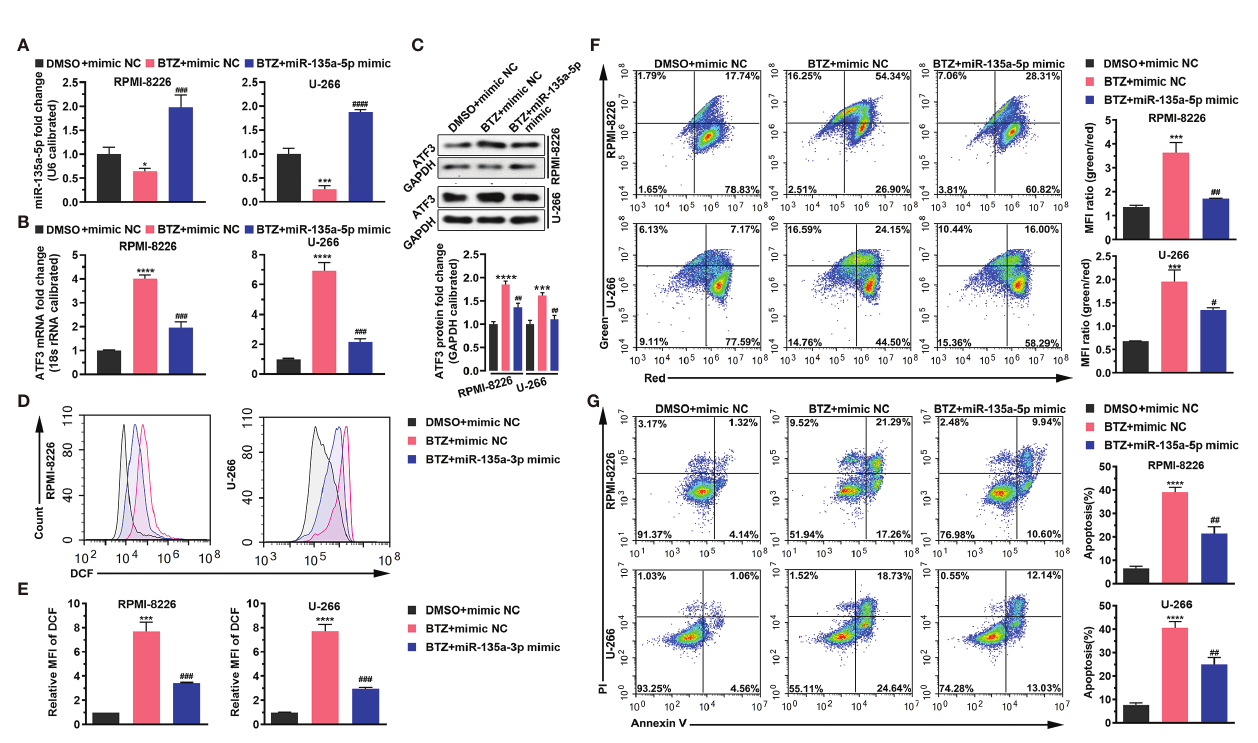
FIGURE 4 | BTZ modulates apoptosis dependently on miR-135a-5p. Apoptosis was analyzed in three groups: (A) . DMSO + mimics NC; (B) BTZ + mimics NC; (C) BTZ + miR-135a-5p mimics. (A) The miR-135a-5p level was analyzed by RT-qPCR in RPMI-8226 and U-266 cells of the three groups. (B) The ATF3 mRNA level was analyzed by RT-qPCR in RPMI-8226 and U-266 cells of the three groups. (C) The ATF3 protein level was analyzed in the three groups. Quanti fi cation of ATF3 band intensity, with values normalized to GAPDH. (D) The ROS level was measured by the Cellular ROS Assay Kit in the three groups. DCF was detected by FACS. (E) Quantitation of the ROS level indicated by DCF. (F) Left panel: The MMP was analyzed by the JC-1 assay. Right panel: Quantitation of the MMP level indicated by MFI. (G) Left panel: Apoptosis was analyzed by annexin-V PI staining. Right panel: Quantitation of the percentage of apoptotic cells. One-way ANOVA, followed by Tukey ’ s post-hoc test was used for statistical analysis. ***P < 0.001 and ****P < 0.0001 compared with the BTZ + mimic NC group; # P < 0.05, ## P < 0.01, ### P < 0.001, and #### P < 0.0001 compared with the BTZ + miR-135a-5p mimic group. *P < 0.05 compared with the BTZ+mimic NC